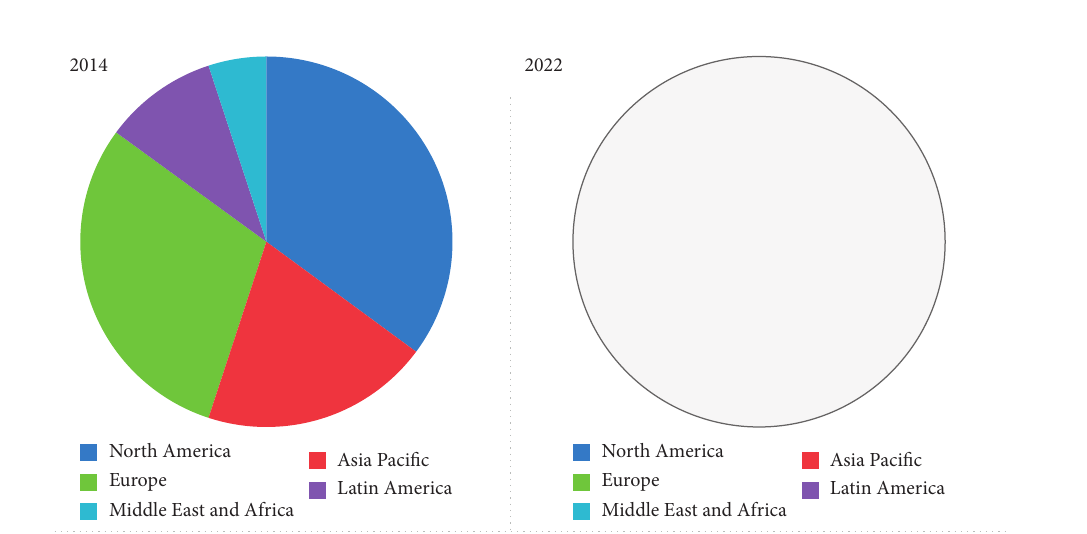
Figure 1: Regional-based IoT market share during